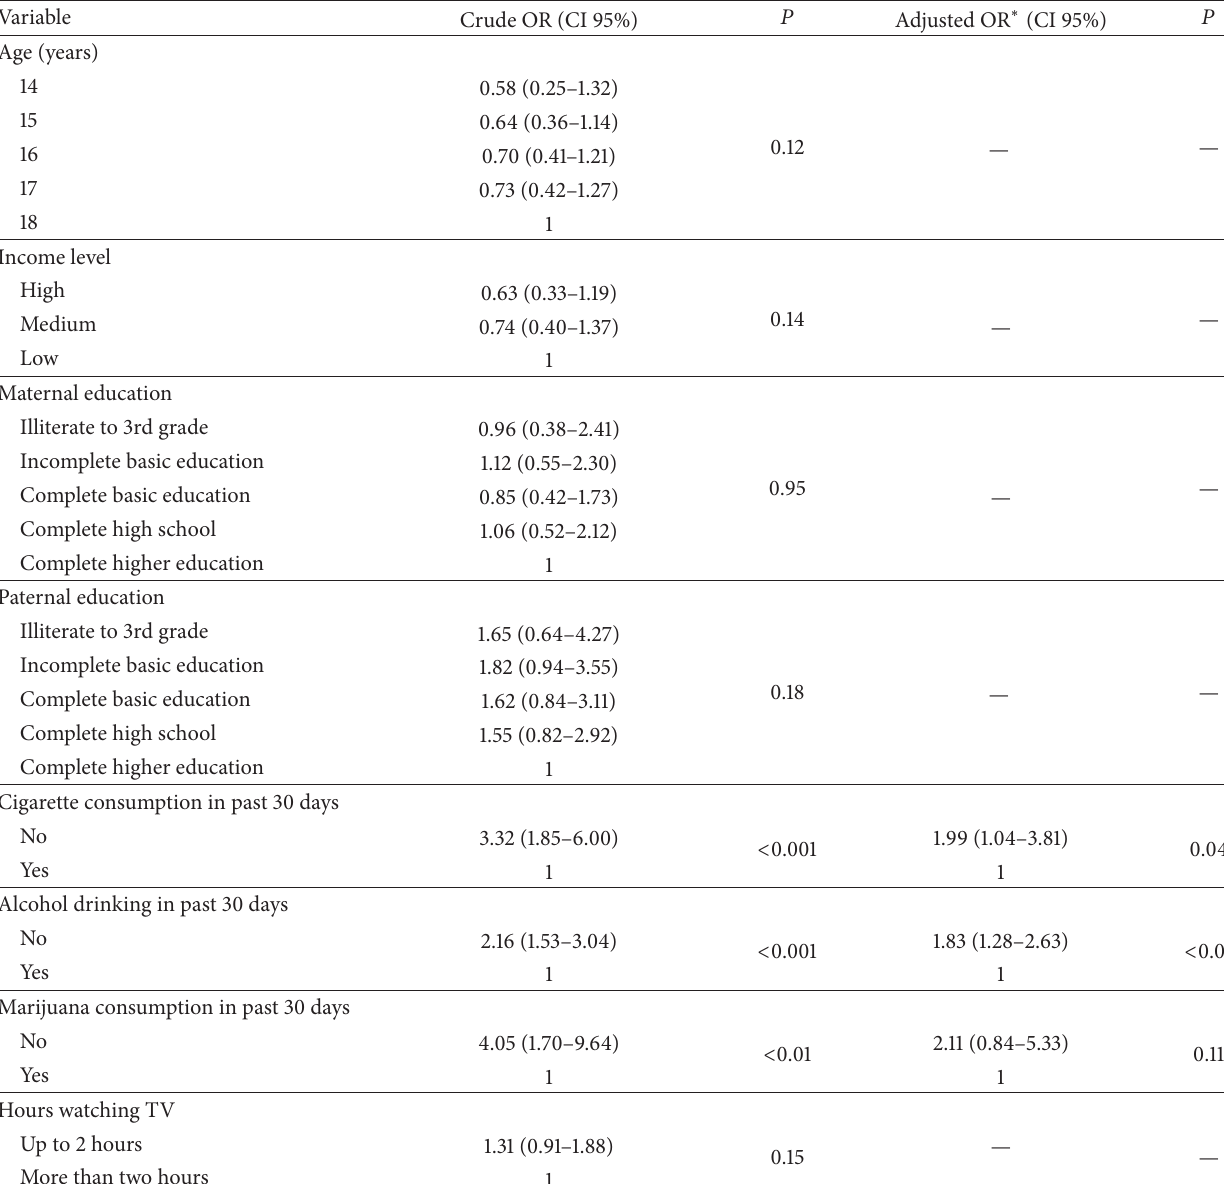
Table 3: Association between violent behavior and associated factors among adolescent males. State of Sergipe, Brazil.